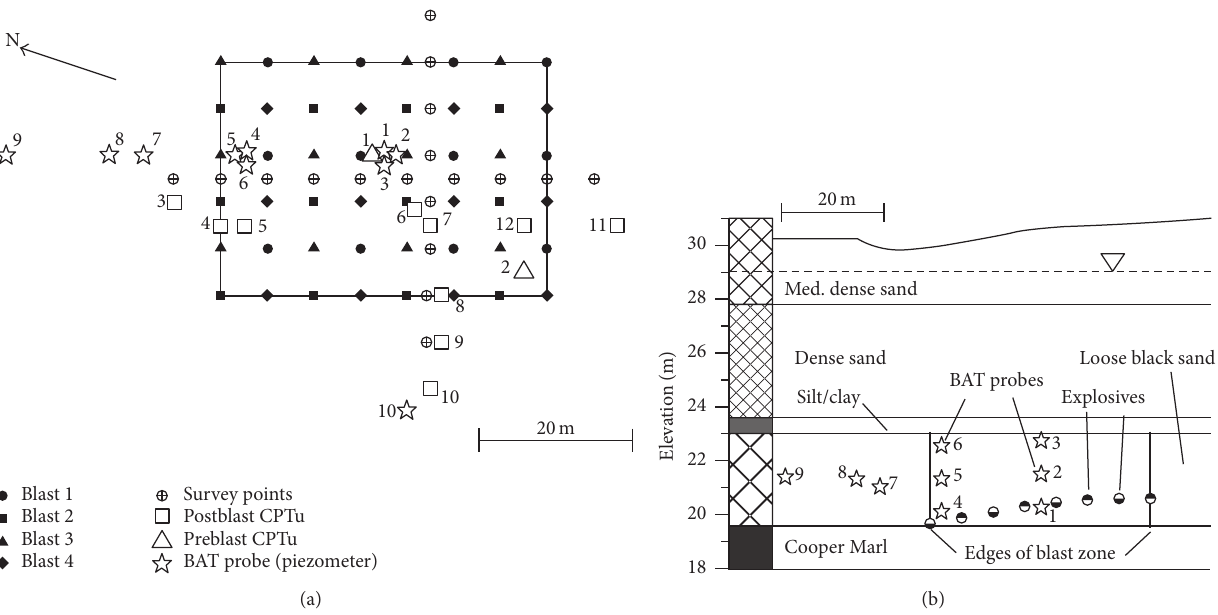
Figure 9: (a) Pattern of blast holes and location of instrumentation. (b) Profile of target layer [31].